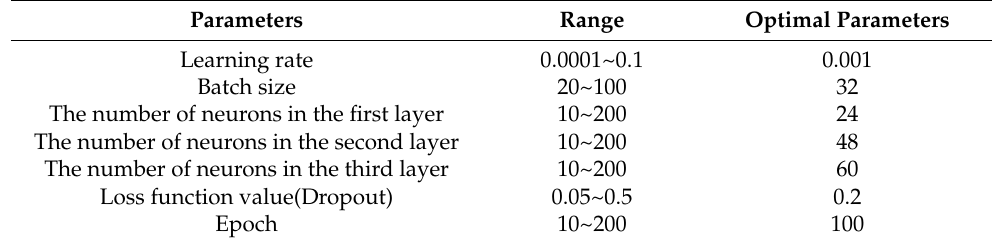
Table 4. Bayesian Optimization